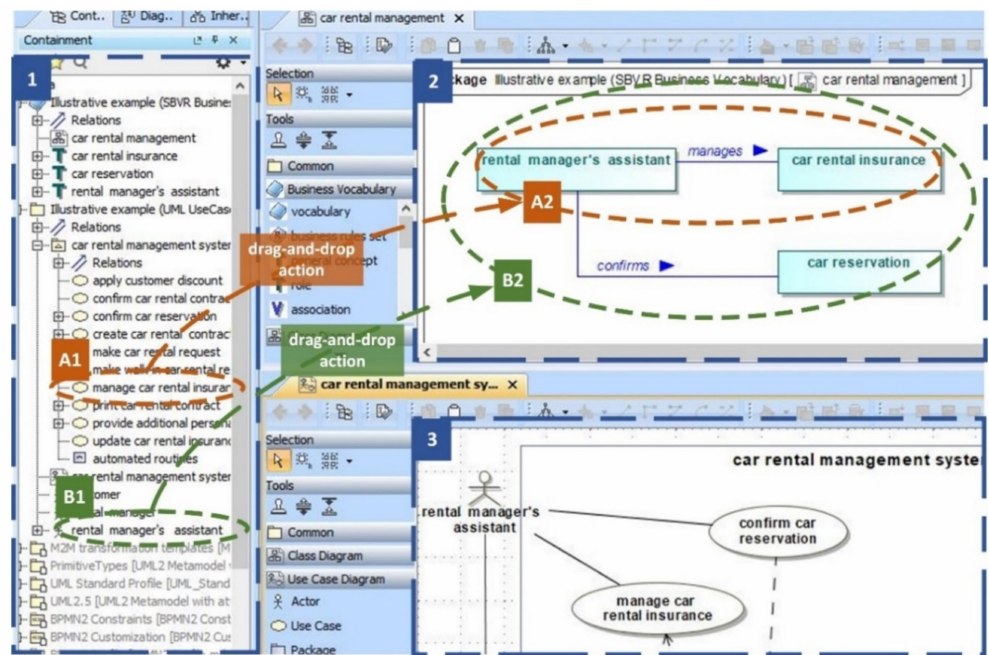
Figure 3. An illustrative example of DnD transformation in action (refer to [6] to view the full specification of the UML use case model and SBVR business vocabulary presented in this